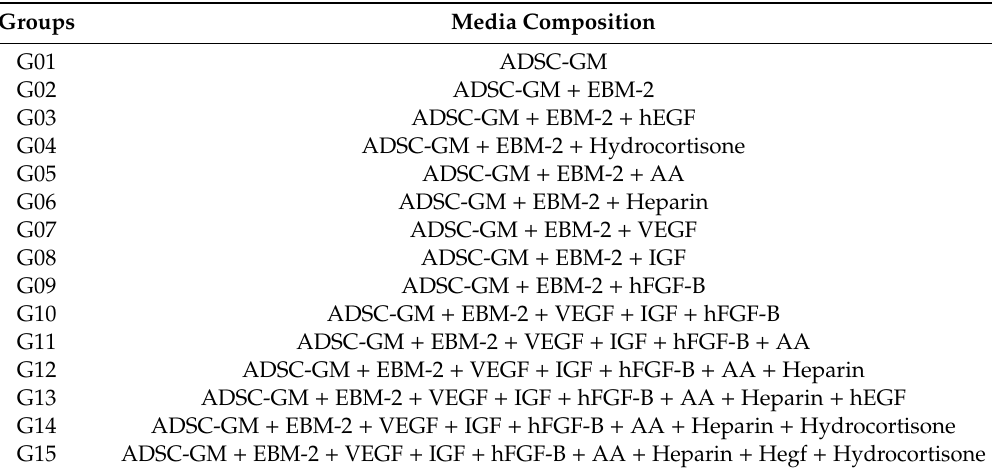
Table 2. Media compositions for the screening of angiogenic factors.